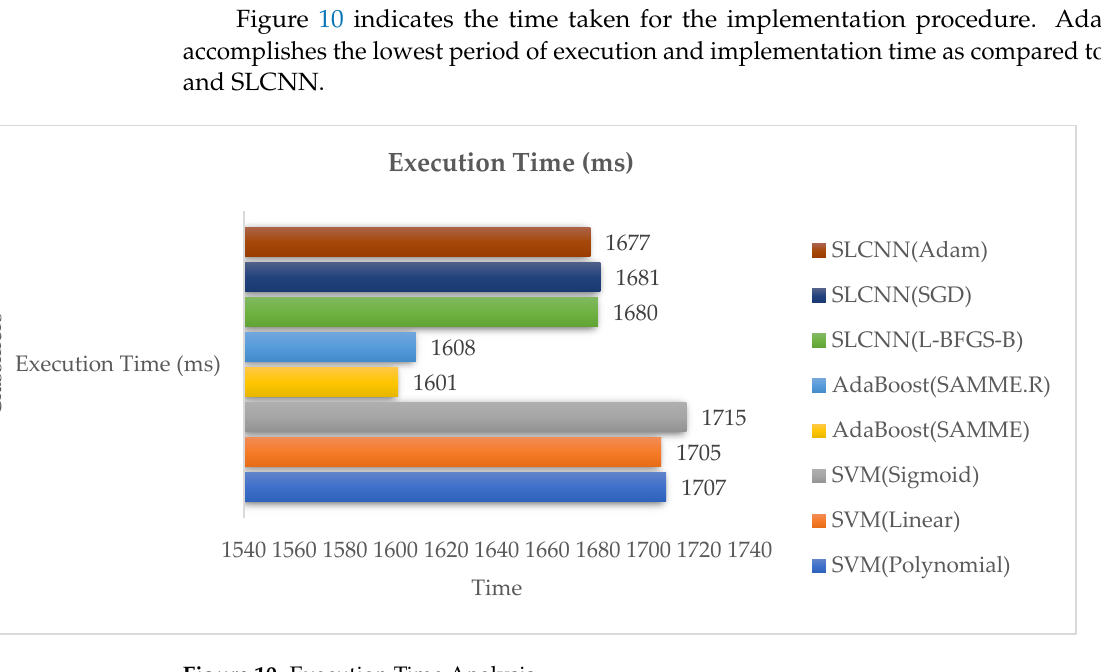
Figure 10. Execution Time Analysis. Table 8 indicates the performance measurements of the identified techniques for text-based sentimental classification from the Guardian dataset during testing. Table 8. Performance Measurement During Testing for Text-Based Sentimental Classification (Testing).